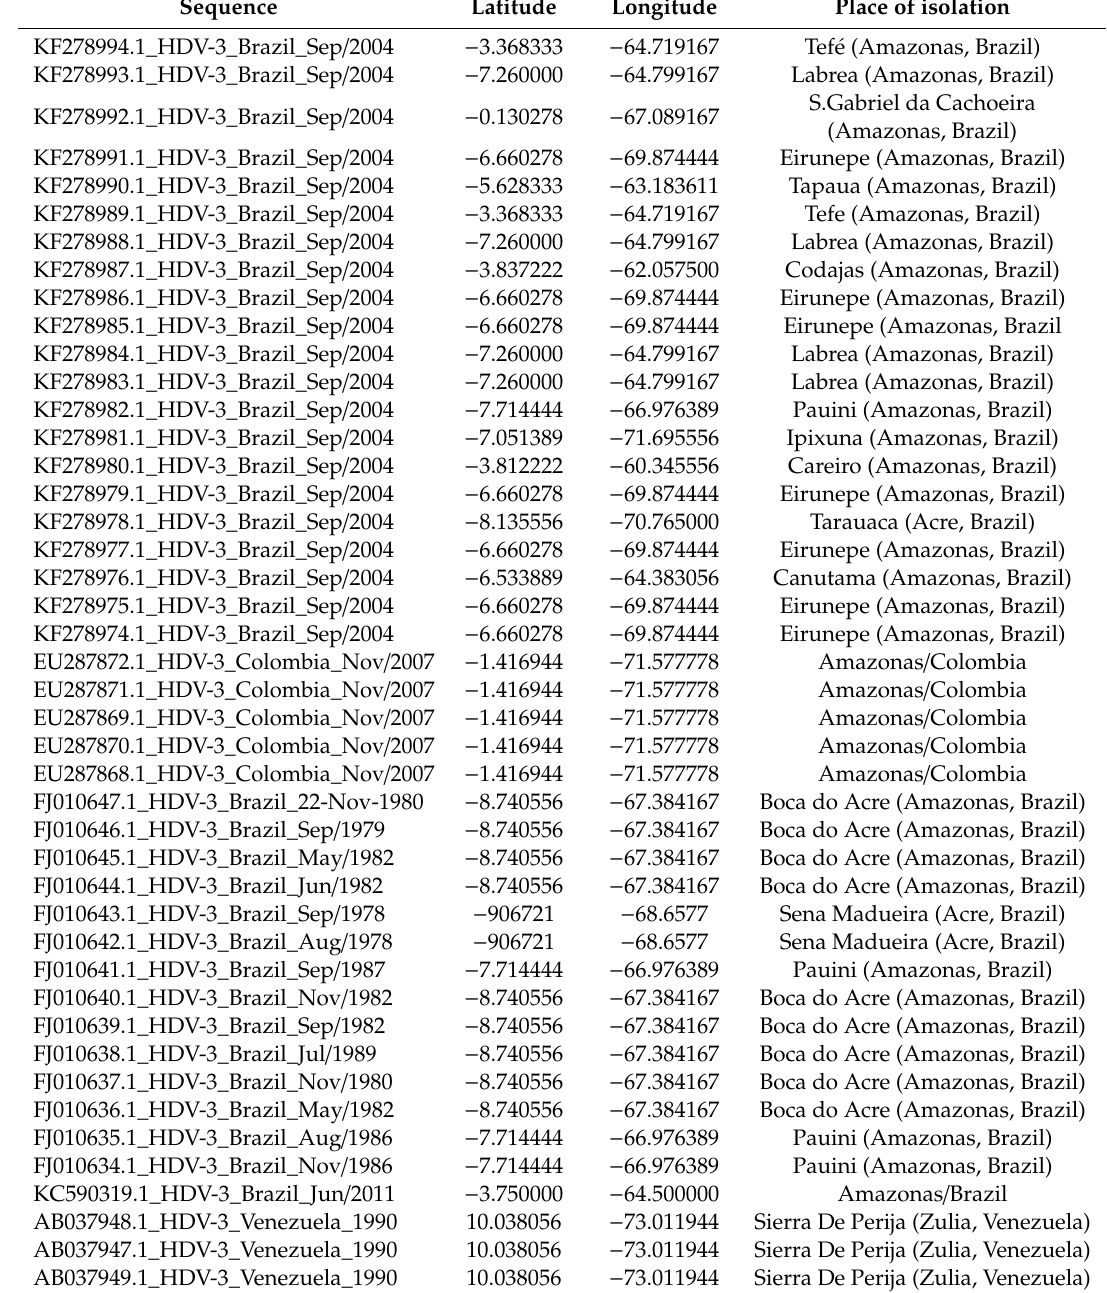
Table 2. Information on place of origin and coordinates